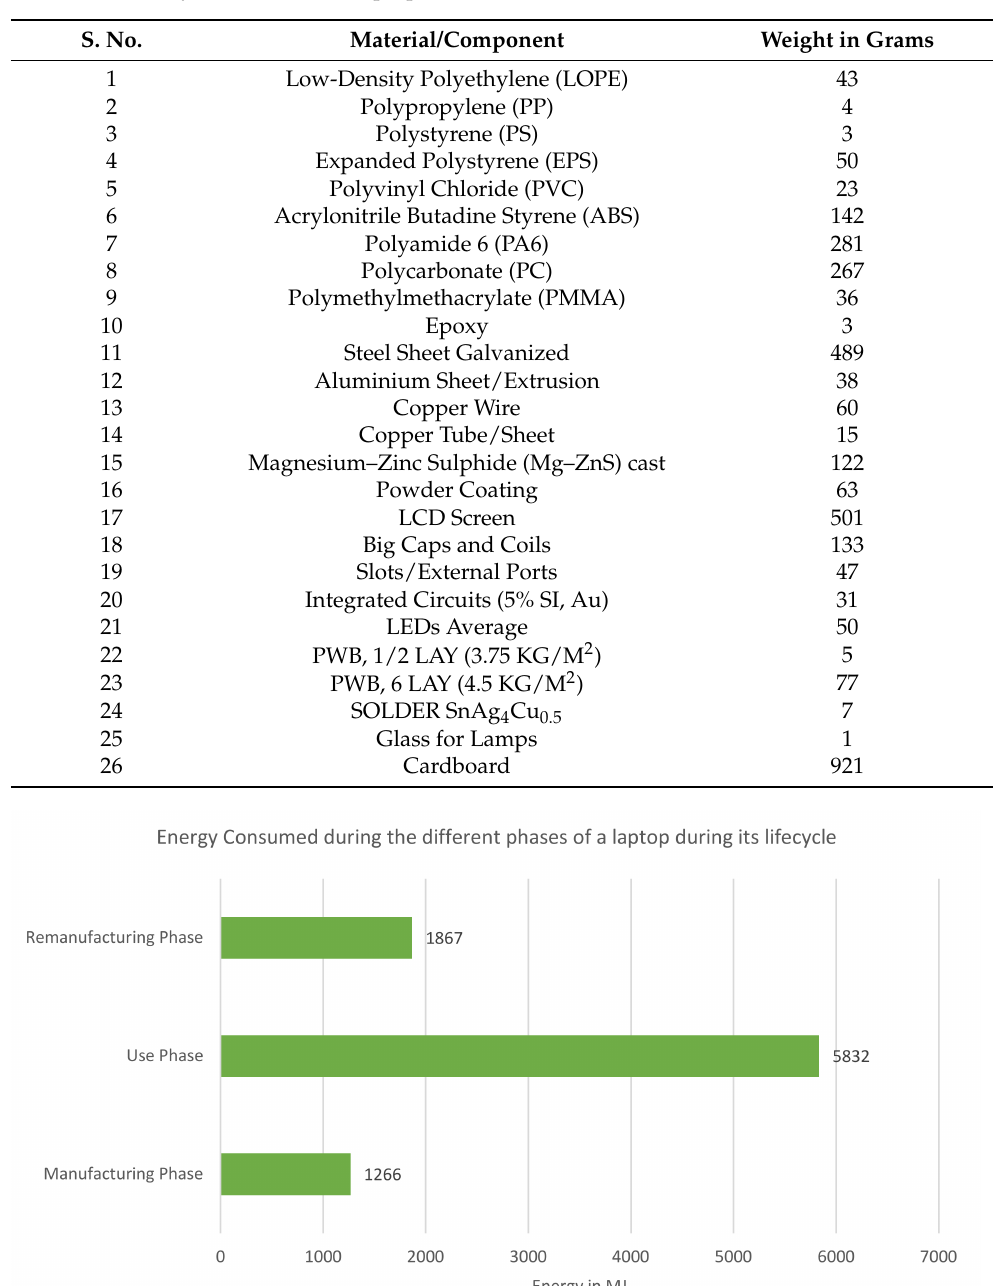
Table 1. Inventory of materials for laptops [15].